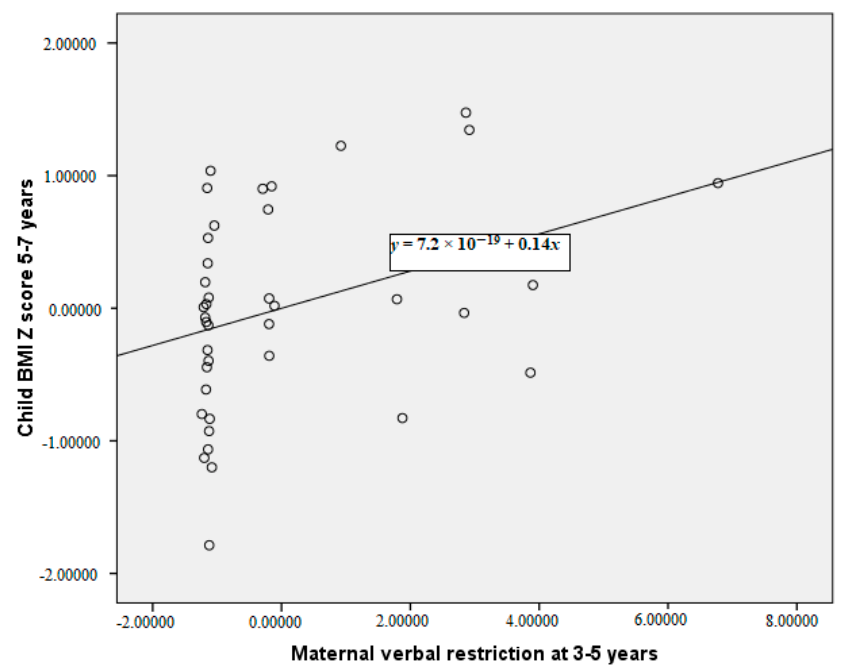
Figure 1. Partial correlation between maternal verbal restriction at 3–5 years and child body mass index (BMI) Z-score at 5–7 years, controlling for child BMI Z-score at 3–5 years (plot of the unstandardised residuals).